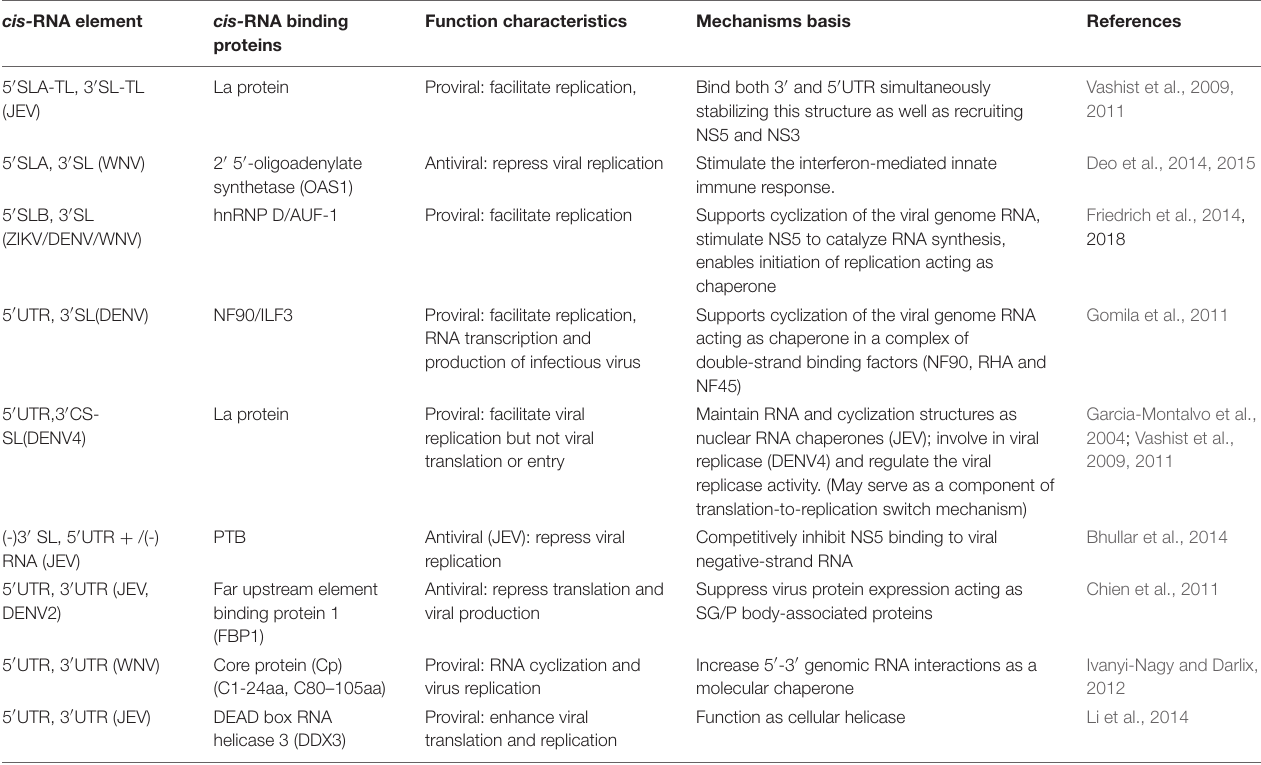
TABLE 1 | Terminal 5 (cid:48) and 3 (cid:48) cis- acting RNAs and their common co-factor proteins. cis- RNA element cis- RNA binding Function characteristics proteins